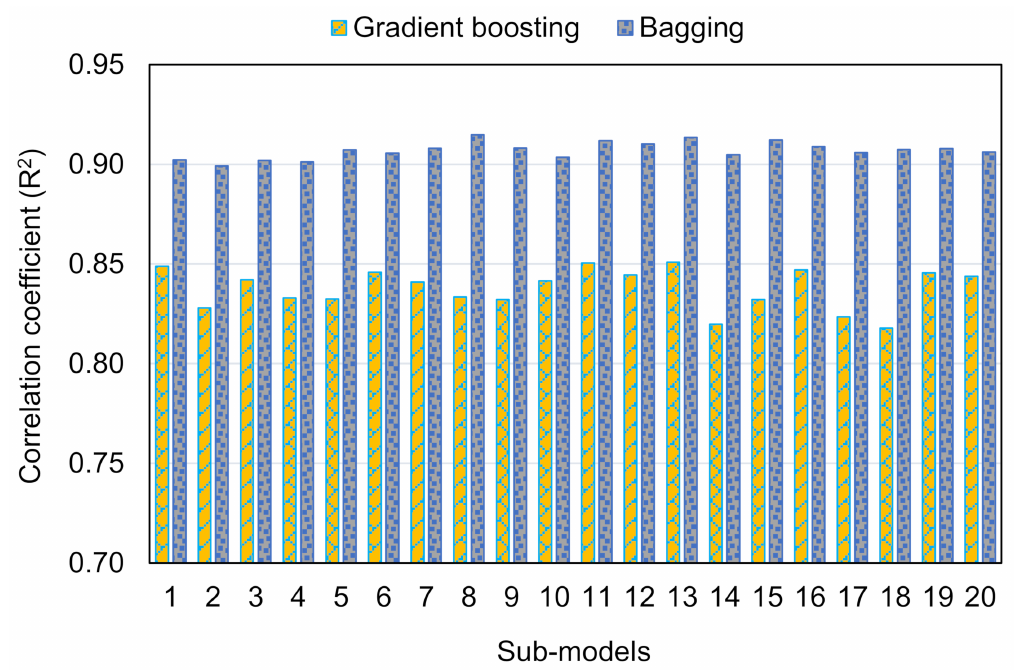
Figure 15. Correlation coefficient of